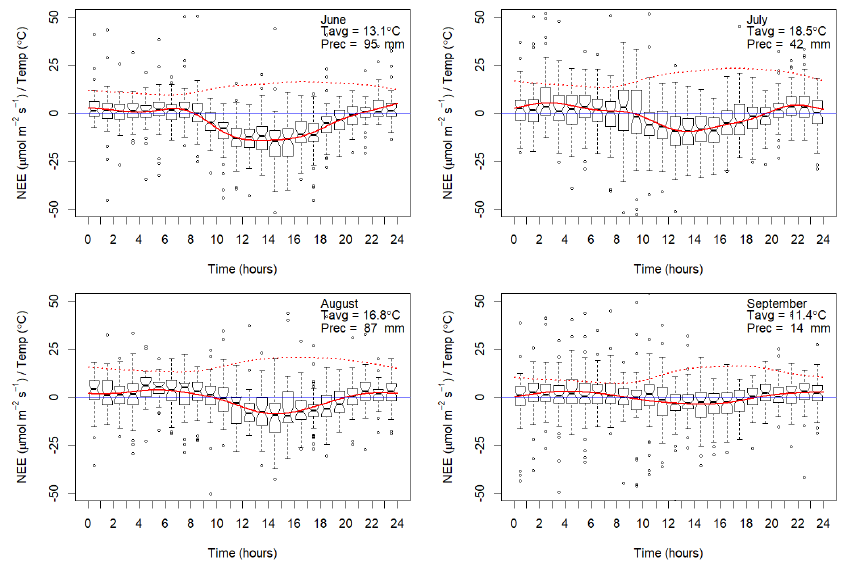
Figure 3. NEE (µmol m −2 s −1 ) values per 24-h timescale and precipitation (mm) levels over the study period (June to September 2014). Dark red line describes smooth mean of the NEE, dotted red line illustrates average temperature.